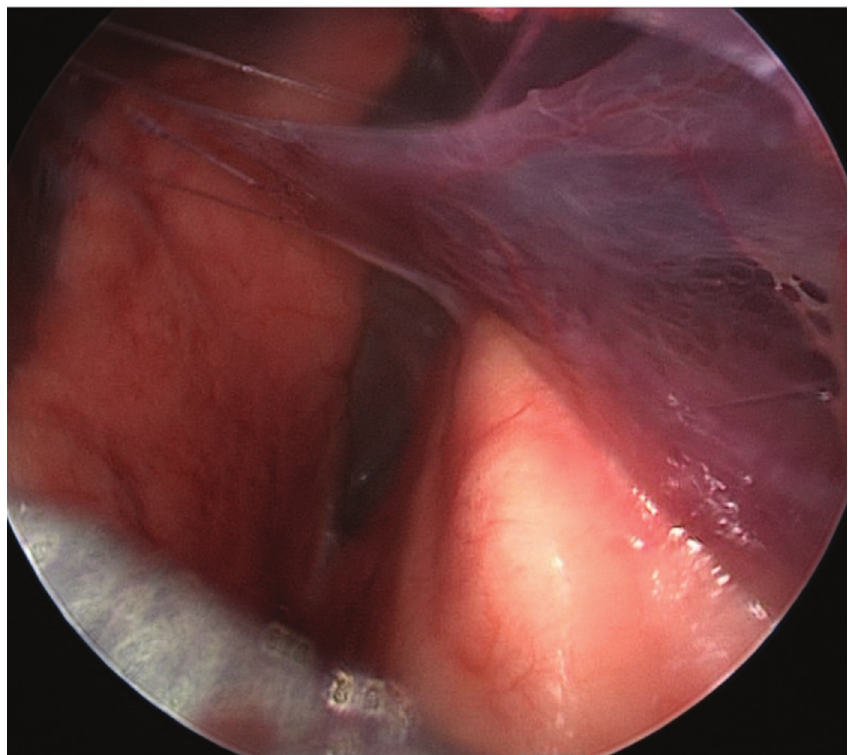
Fig. 2 Presence of numerous adhesions between the visceral and the parietal pleura in the patient described as case